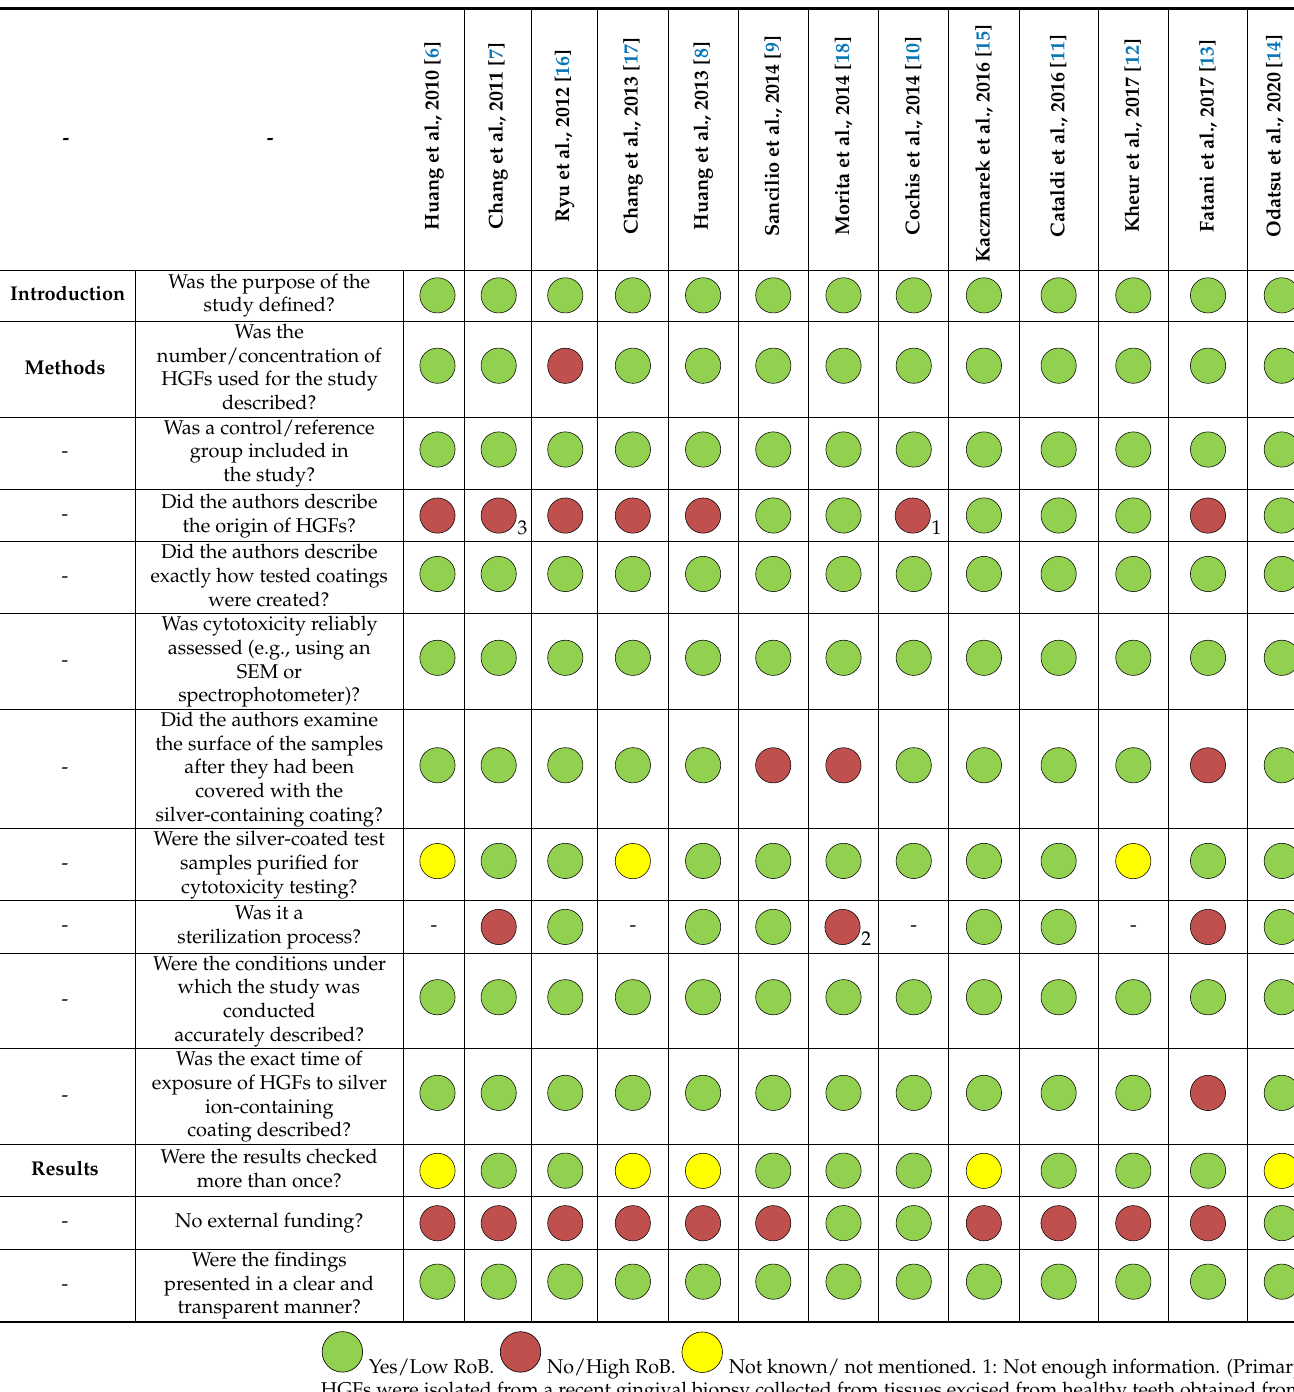
Table 1. The RoB evaluation according to the analysis developed by the